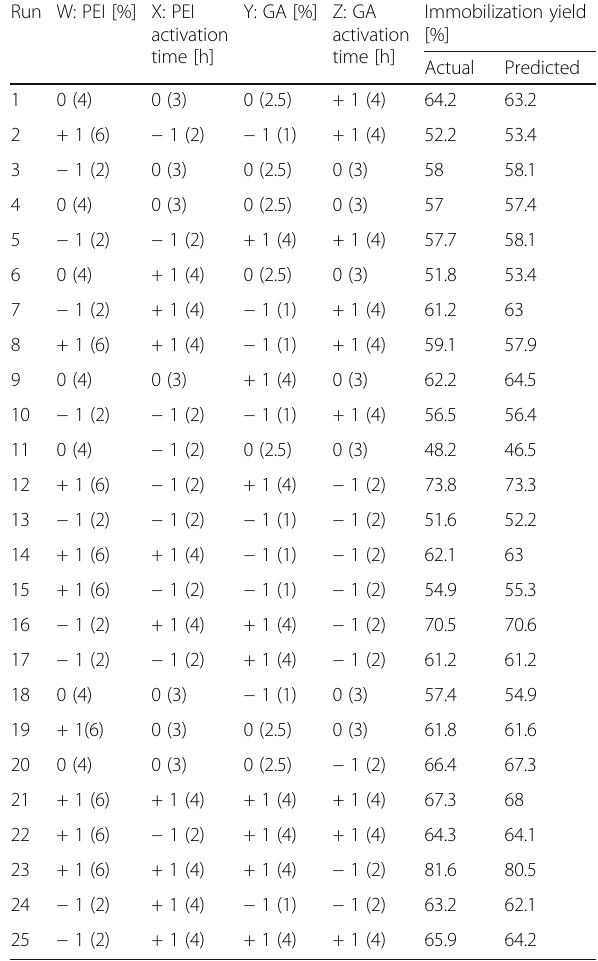
Table 1 CCD experimental and predicted values of Ch-MNP/ PEI/GA/ α -amylase immobilization